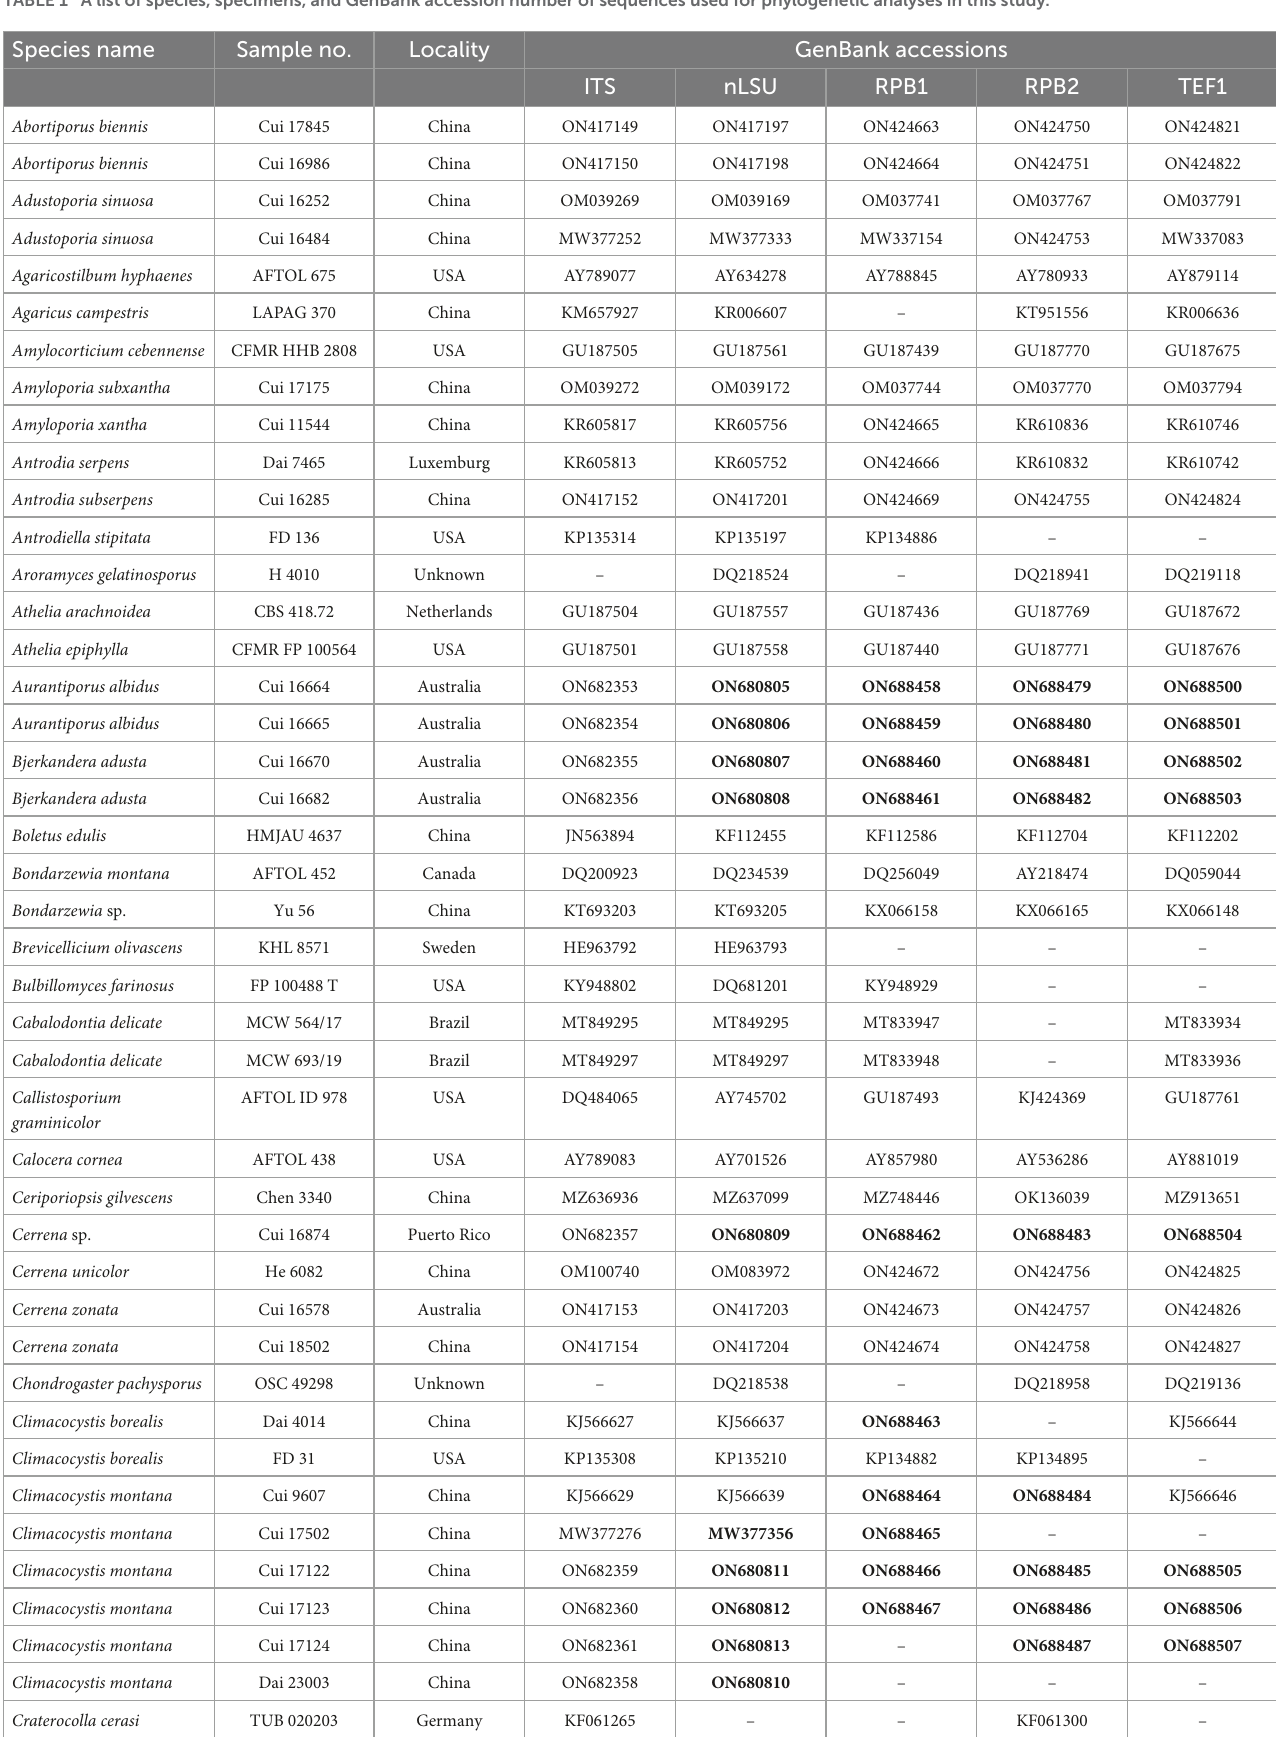
TABLE 1 A list of species, specimens, and GenBank accession number of sequences used for phylogenetic analyses in this